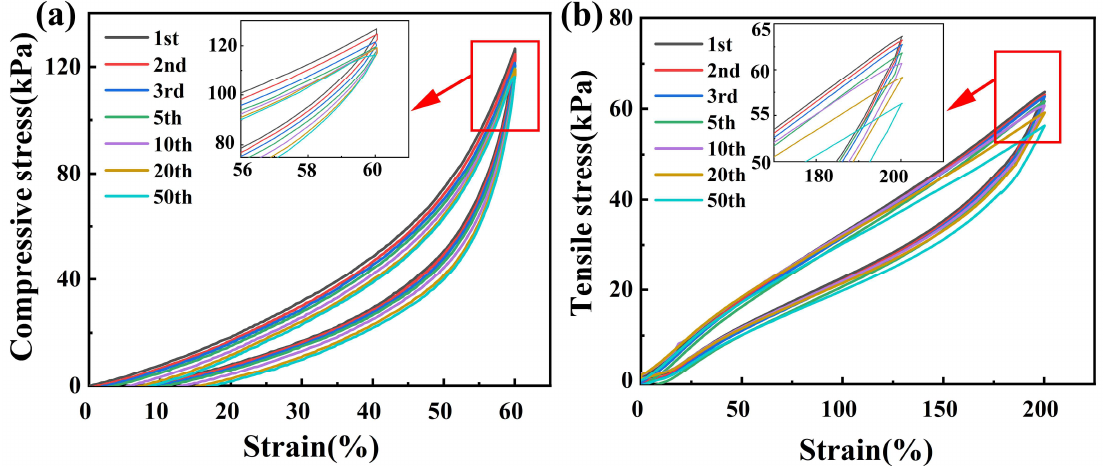
Figure 4. The loading-unloading tests of N 5 H 5 L. ( a ) cyclic compressive stress–strain curves at 60% strain for 50 cycles; ( b ) cyclic tension stress–strain curves at 200% strain for 50 cycles.